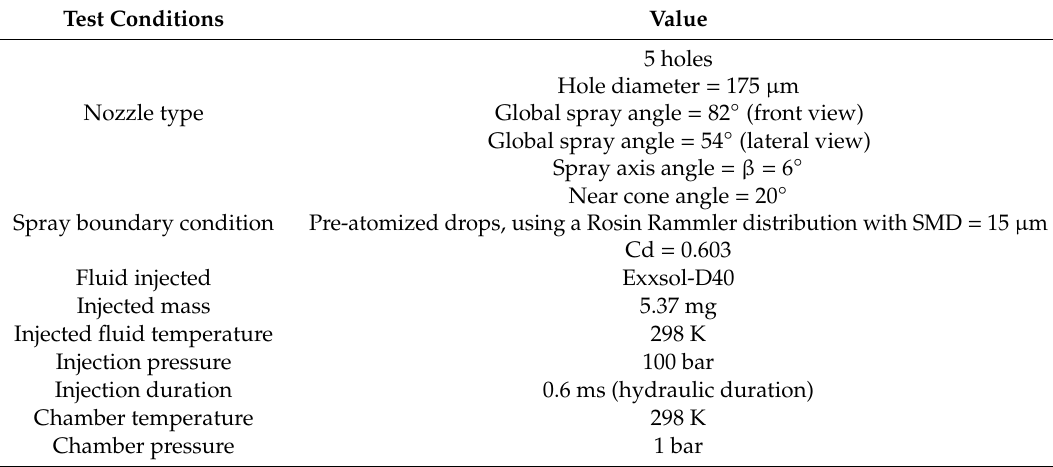
Figure 3. Comparison of simulated and measured droplet diameters at various transverse locations at 15 mm from the tip under conditions specified in Table 3. ( a ) average diameter (D10); ( b ) predicted SMD (D32). Table 4. Gasoline Injector and vessel test